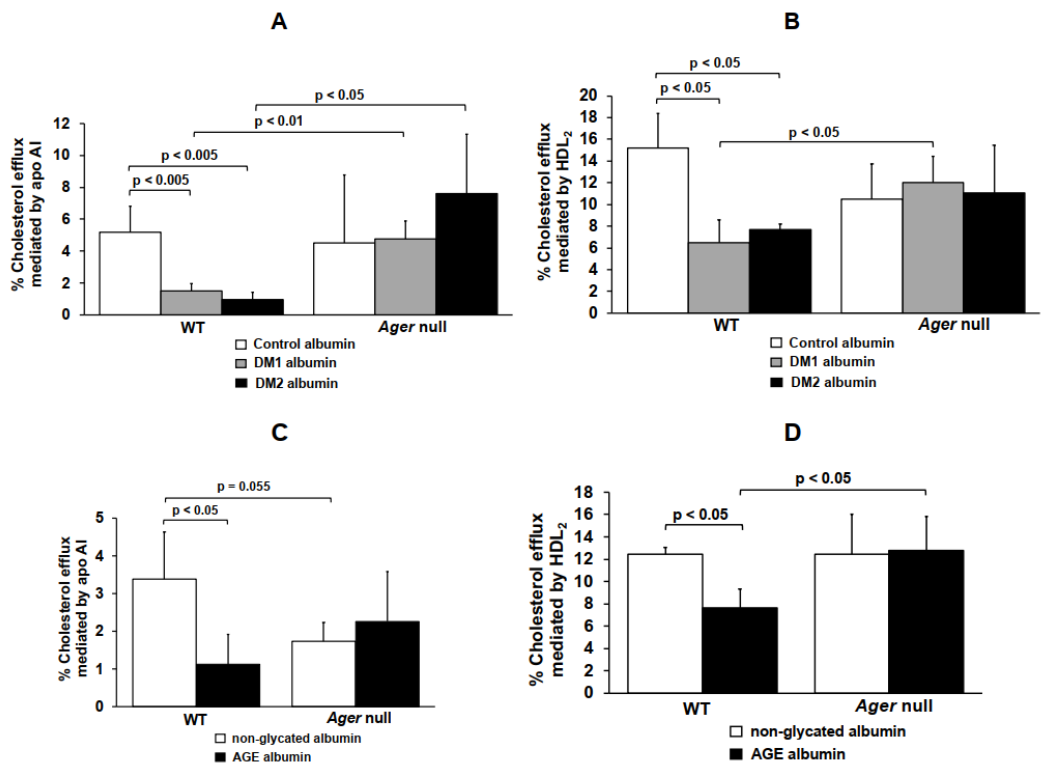
Figure 1. Cholesterol efflux mediated by apo AI and HDL2 in macrophages treated with non-glycated, AGE, control, DM 1 or DM 2 albumin. Bone marrow-derived macrophages (BMDMs) from C57BL / 6 WT (n = 4) mice and Ager null (n = 4) mice were loaded with acetylated LDL (50 µ g / mL) and 3H-cholesterol for 24 h. Cells were treated for 48 h with (A and B) control, DM 1 or DM 2 albumin or with (C and D) non-glycated or AGE albumin (1 mg / mL in DMEM). Apo A-I (30 µ g / mL) or HDL2 ((50 µ g / mL) were utilized as 3H-cholesterol acceptors in 6-h incubations. One-way ANOVA—Dunnett´s posttest; mean ±